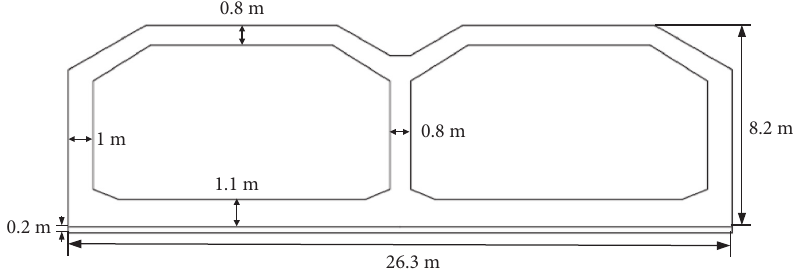
Figure 1: Tunnel cross